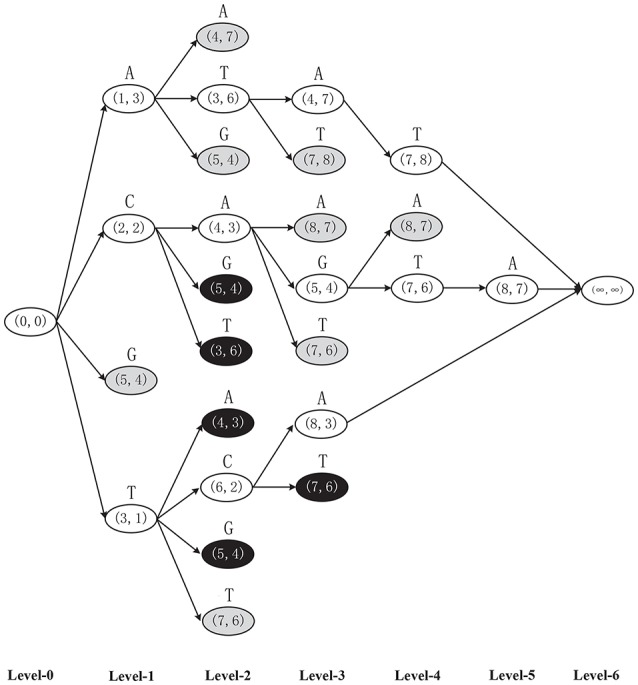
The DAG of two sequences ACTAGCTA and TCAGGTAT constructed by the general dominant point based algorithms, in which the black and gray nodes will be eliminated by the Minima operation.